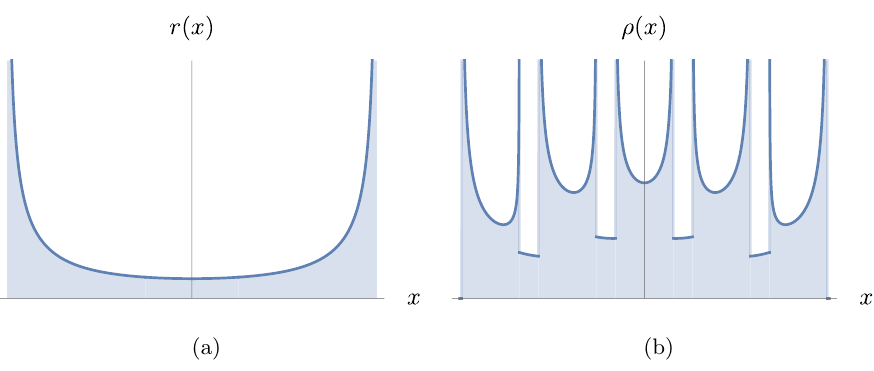
Figure 2 . From the resolvent (a) to the eigenvalue density